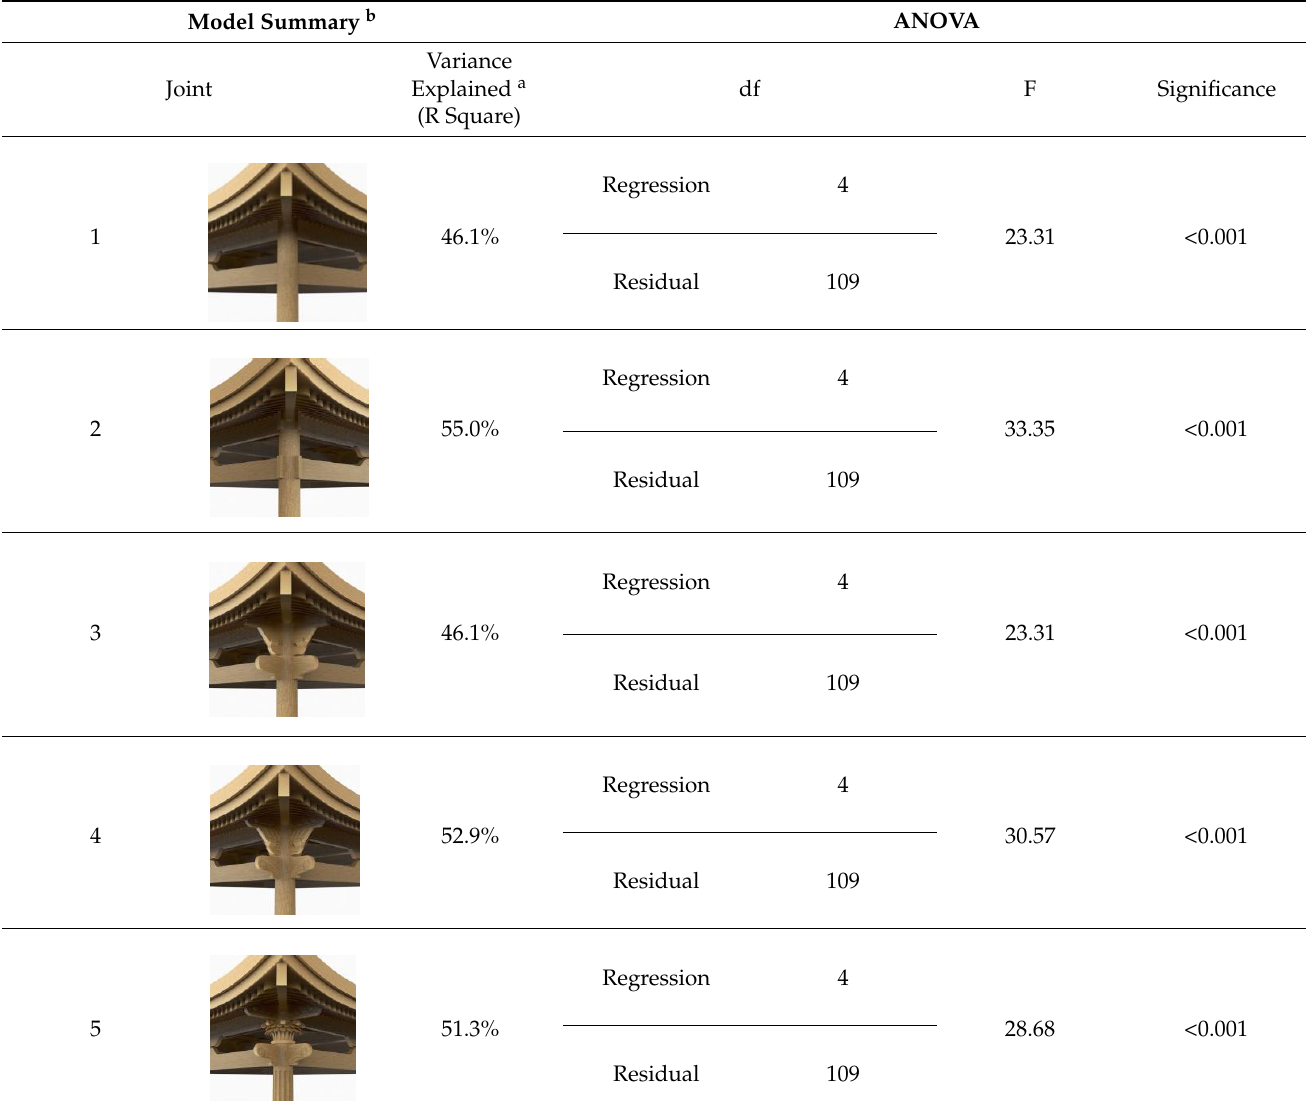
Table 2. Summary (b) of the model predicting overall aesthetic preference and statistical significance of the models.